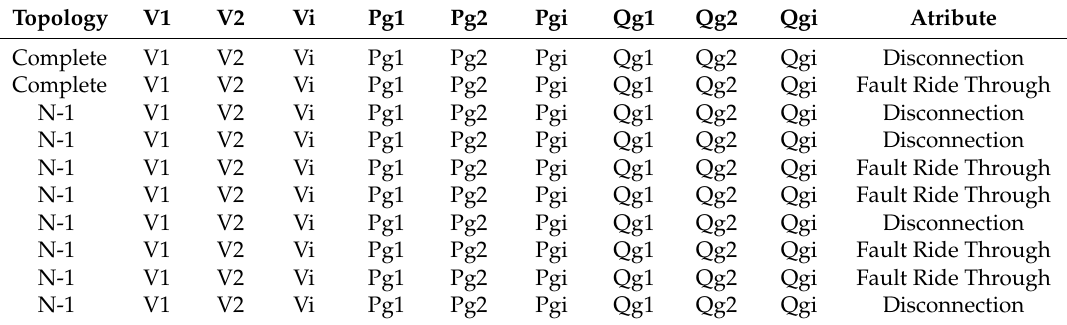
Table 1. Systemic database structure.